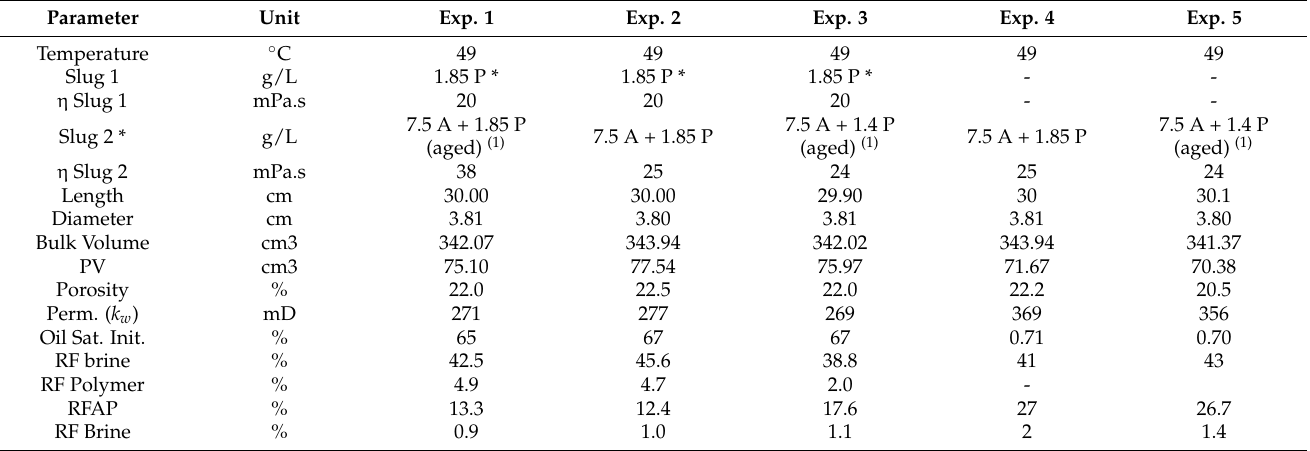
Table 9. Summary of results obtained for Bentheimer outcrop flood experiments performed in this work. Core orientation was vertical, pore pressure was 5 bar, injection rate was 1 ft/day, and radial pressure was 30 bar in all cases. Viscosities are taken at 7.94 s − 1